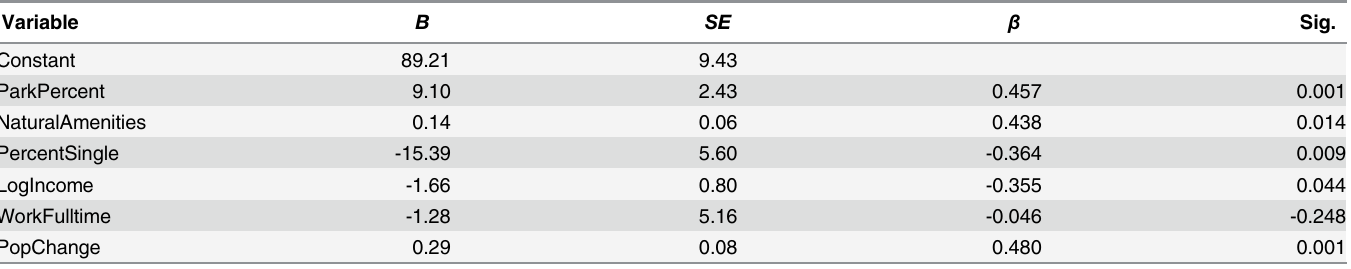
Table 4. Parameter Estimates for Best-fitting OLS Regression Model a Depicting Factors Associated with Overall Wellbeing Index Scores for U.S. Cities (n = 44).